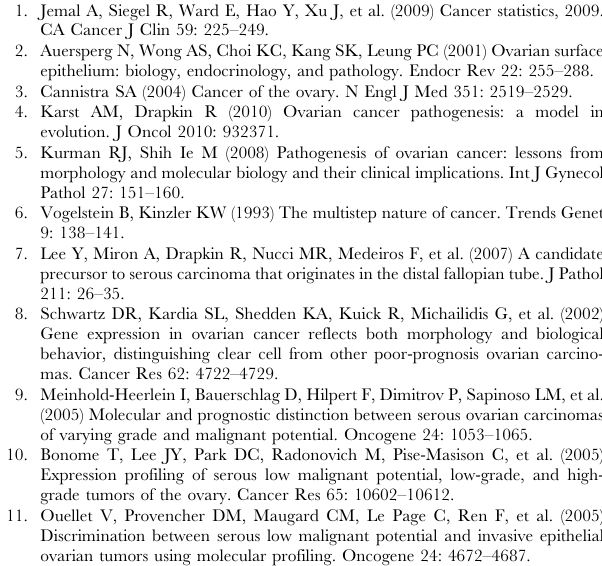
Table S2 Differentially Expressed Microtubule and Microtubule Associated Genes in MOSE cell